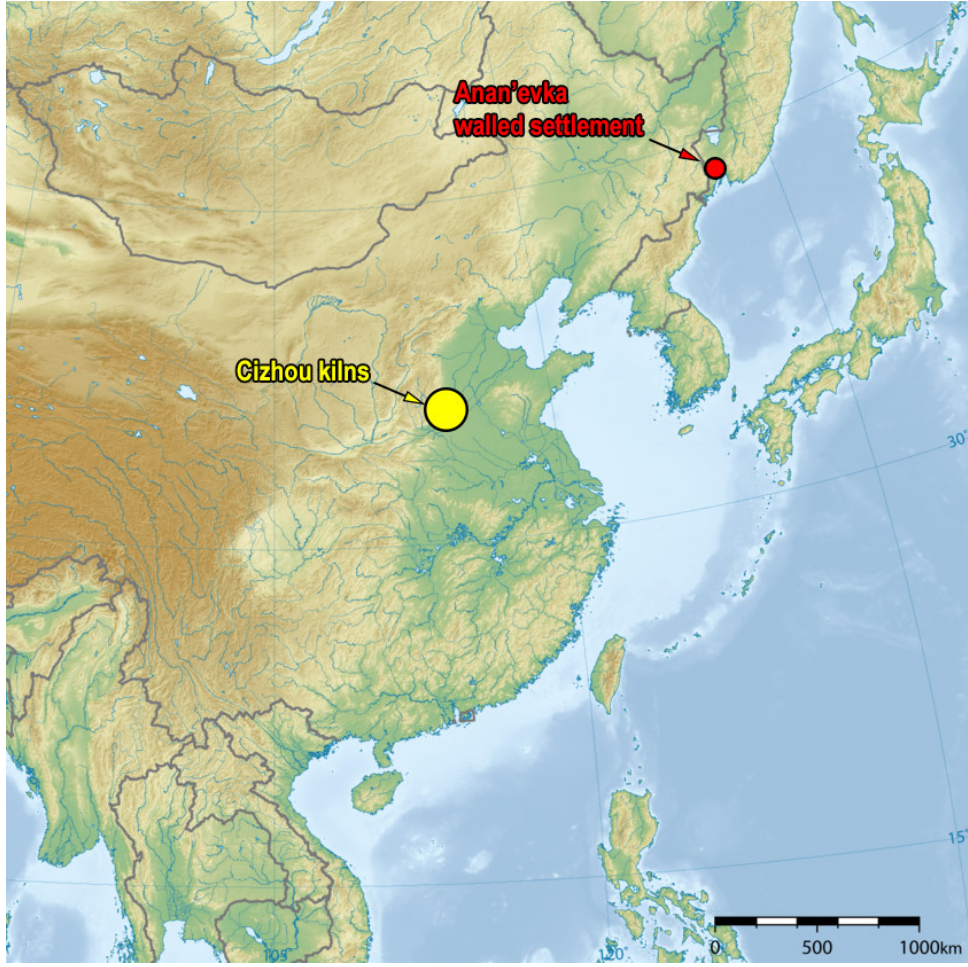
Figure 13. Location of the Cizhou kiln and Anan’evka walled settlement at the map of the Asia-Pacific Region.